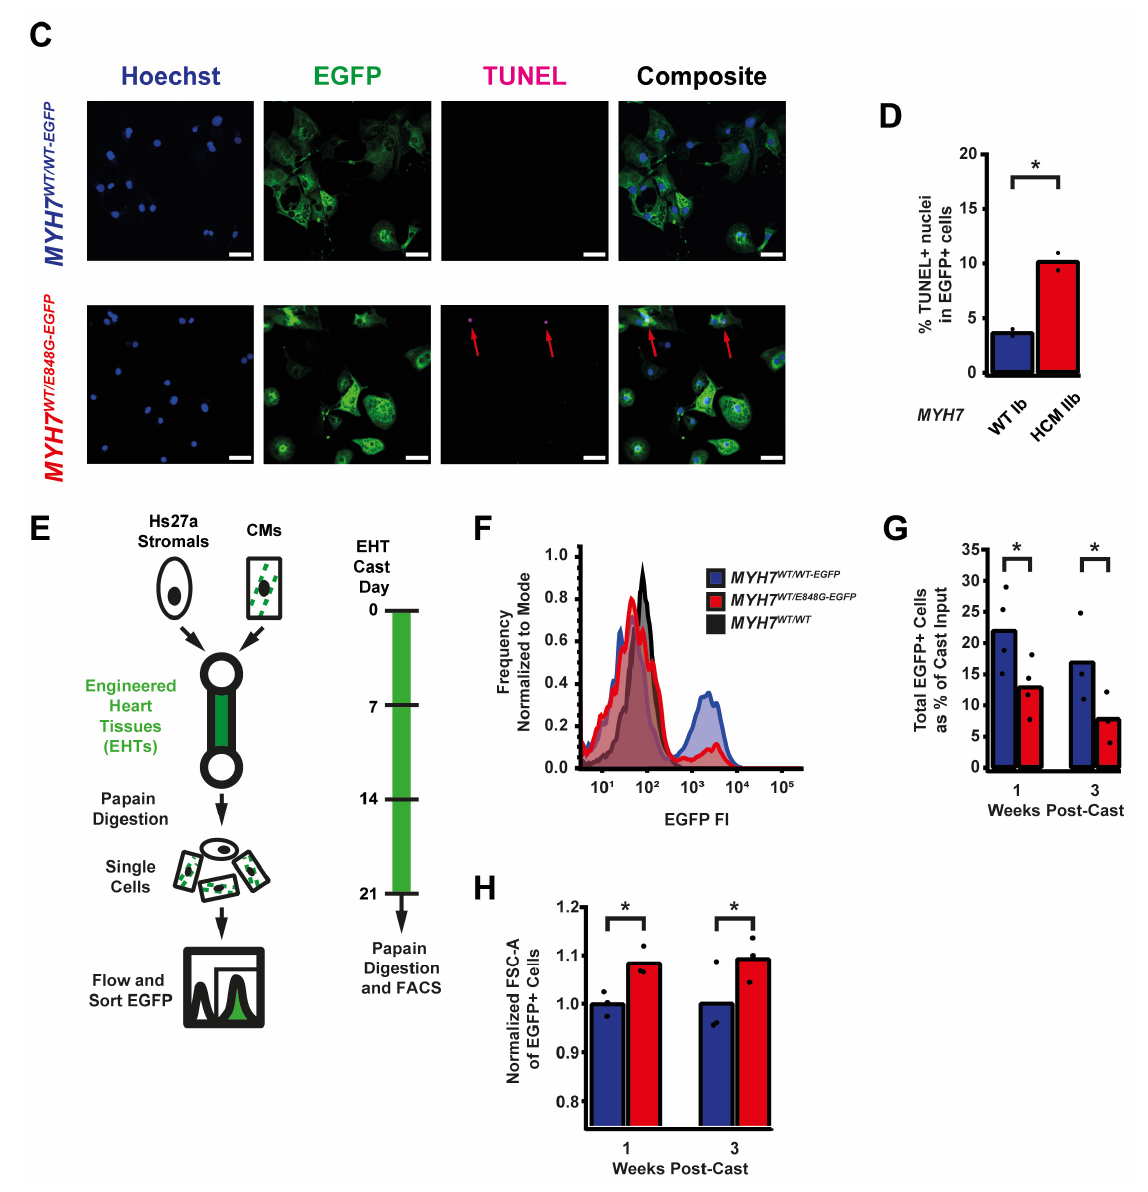
Figure 2. MYH7 E848G reduces hiPSC-CM survival in monolayer and EHT culture. ( A ) Schematic of iPSC-CM differentiation and seeding protocol for monolayer culture. ( B ) Total EGFP+ cell count for isogenic hiPSC-CMs and cTnT + cell count for patient-derived hiPSC-CMs in DMEM-based monolayer culture, normalized to day 2 post-seed. Mean ± SEM, n = 4–6 biological replicates. * indicates p < 0.05 significance calculated with Student’s t-test for relative survival values at day 12 post-seed. ( C ) Representative confocal microscopy images for Hoechst- and TUNEL-stained MYH7 WT/WT-EGFP and MYH7 WT/E848G-EGFP hiPSC-CMs, differentiation day 33. Positive TUNEL signal indicated with arrows. Scale bar 50 µ m. ( D ) Quantification of percentage of TUNEL + nuclei in EGFP + hiPSC-CMs from ( C ), n = 2 biological replicates shown, n = 150 cells per replicate. ( E ) Schematic for casting protocol for engineered heart tissues (EHTs) and papain-based digestion for FACS-based analysis. ( F ) Representative histogram of EGFP intensity as measured with flow cytometry in MYH7 WT/WT , MYH7 WT/WT-EGFP , and MYH7 WT/E848G-EGFP EHTs, cast week 1. n = 10,000 cells. ( G ) Total EGFP + cellsaspercentageofinitialEHTcastinputfor MYH7 WT/WT-EGFP and MYH7 WT/E848G-EGFP EHTs,cast week 1 and 3, as measured with FACS. Mean and cast replicates shown, 3–6 tissues per cast. ( H ) Normalized FSC-A of EGFP + cells in MYH7 WT/WT-EGFP and MYH7 WT/E848G-EGFP EHTs, cast week 1 and 3, as measured with fluorescence-activated cell sorting (FACS). Mean and cast replicates shown, 3–6 tissues per cast. * in ( D , G , H ) indicates p < 0.05 significance calculated with Student’s t